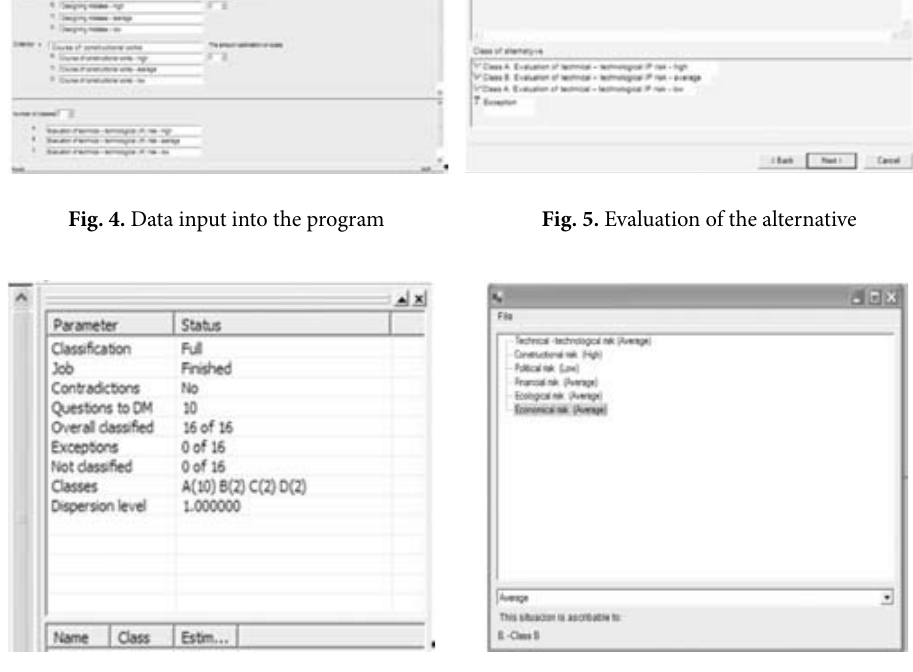
Fig. 6. The data of program Fig. 7. Data base (I hierarchy